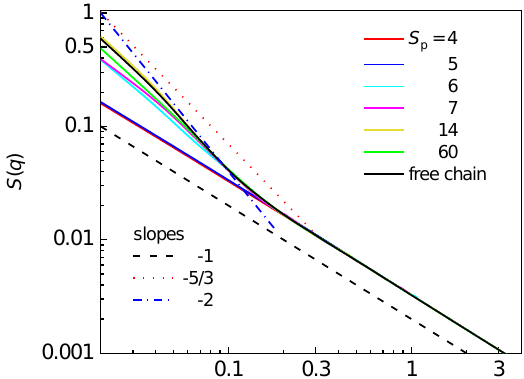
Figure 6. Structure factor for a semiflexible chain confined in an array of nanoposts of fixed post diameter d p = 3.9 and various post separations S p . The solid lines represent the characteristic slopes that might be expected for a semiflexible chain confined in a symmetric channel.